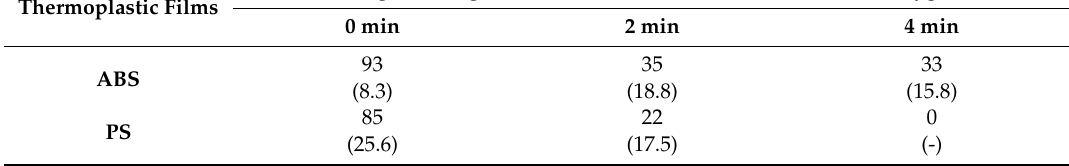
Table 4. Measured water contact angle of the studied thermoplastic films (the coe ffi cient of variation (CV) in % is in brackets below the mean